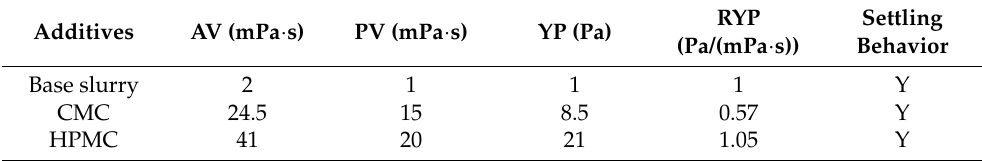
Table 1. Rheology and stability of the slurry after the addition of cellulosic polymers. Additives